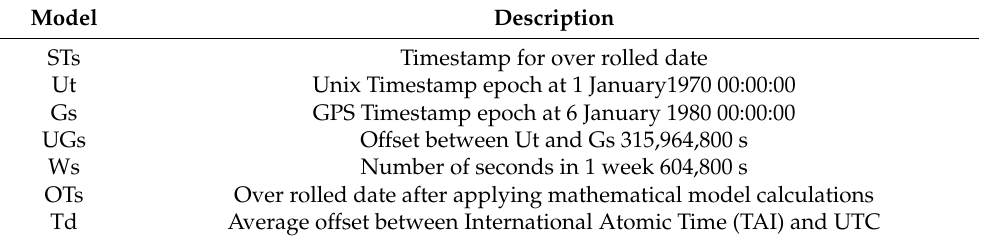
Figure 1. Week number ranges for different GNSS systems. Table 3. Mathematical symbols used in mathematical representation.